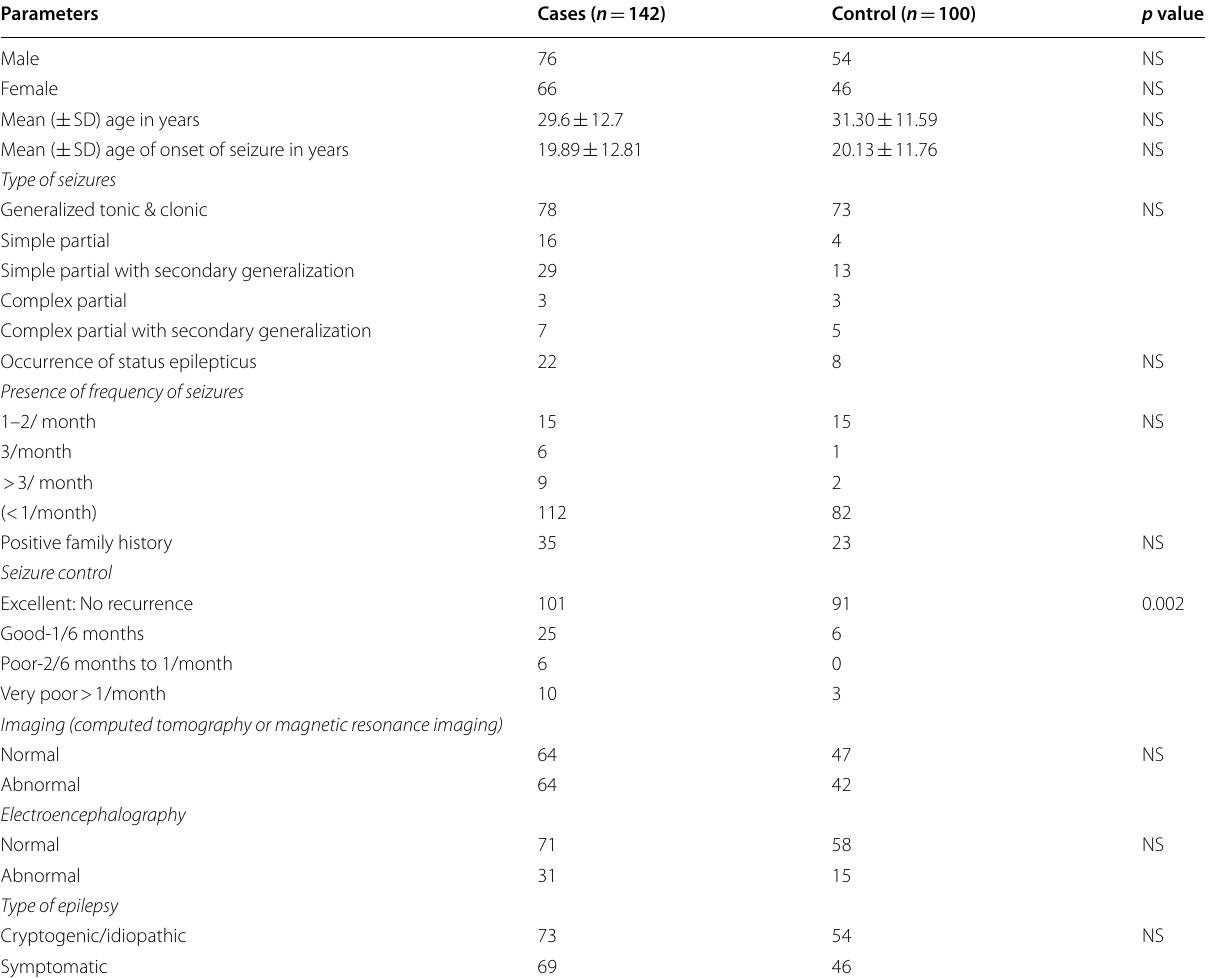
Table 1 Demographic profile of the patients with and without DPH-induced ADRs